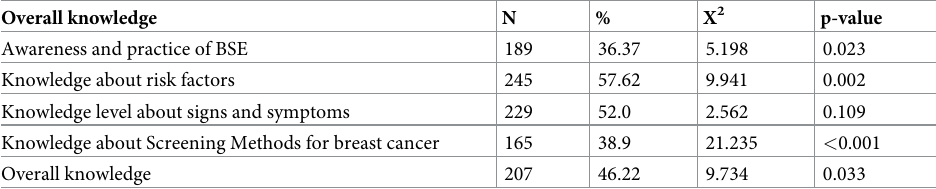
Table 3. Respondents’ overall knowledge towards breast cancer.